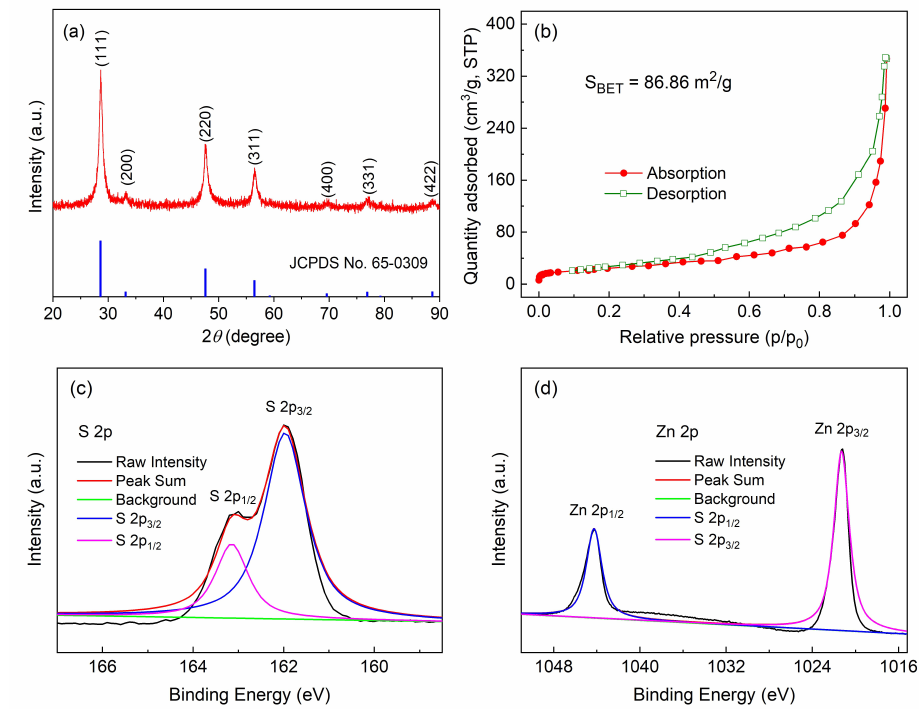
Figure 2. ( a ) XRD pattern of the ZnS nanotubes; ( b ) N 2 adsorption-desorption isotherm of the ZnS nanotubes; ( c , d ) XPS analysis for the ZnS nanotubes. nanotubes; ( c , d ) XPS analysis for the ZnS